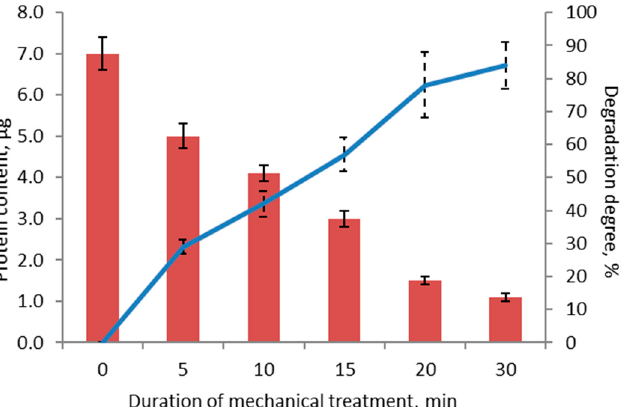
Figure 8. Protein content in milk protein isolate before and after mechanical treatment for 5, 10, 15, 20, and 30 min.